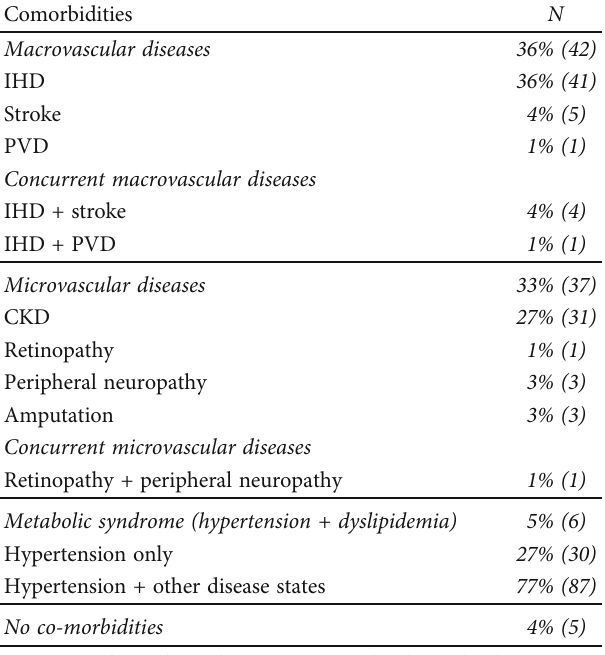
Table 3: Description of comorbidities present in the study population. Type 2 diabetes related comorbidities in the study population ( n = 113